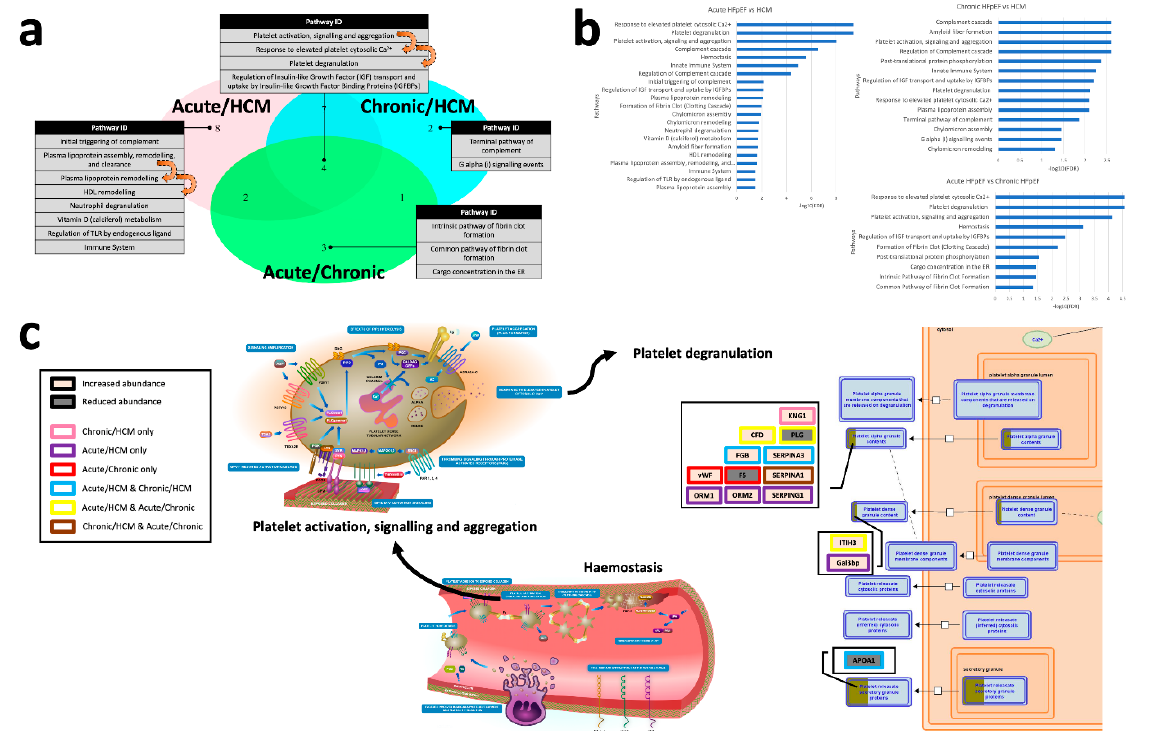
Figure 3. Pathway analysis. ( a ) Triple Venn diagram illustrating the number of pathways signifi- cantly changed in acute HFpEF vs. HCM, chronic HFpEF vs. HCM and acute HFpEF vs. chronic HFpEF. ( b ) Representation of all significantly altered pathways between the three comparison groups in order of significance (x-axis is − log 10 (FDR)); and ( c ) for the pathway of platelet degranu- lation in response to elevated platelet cytosolic Ca 2+ . IGF, insulin-like growth factor; and IGFBP, insulin-like growth factor binding protein.